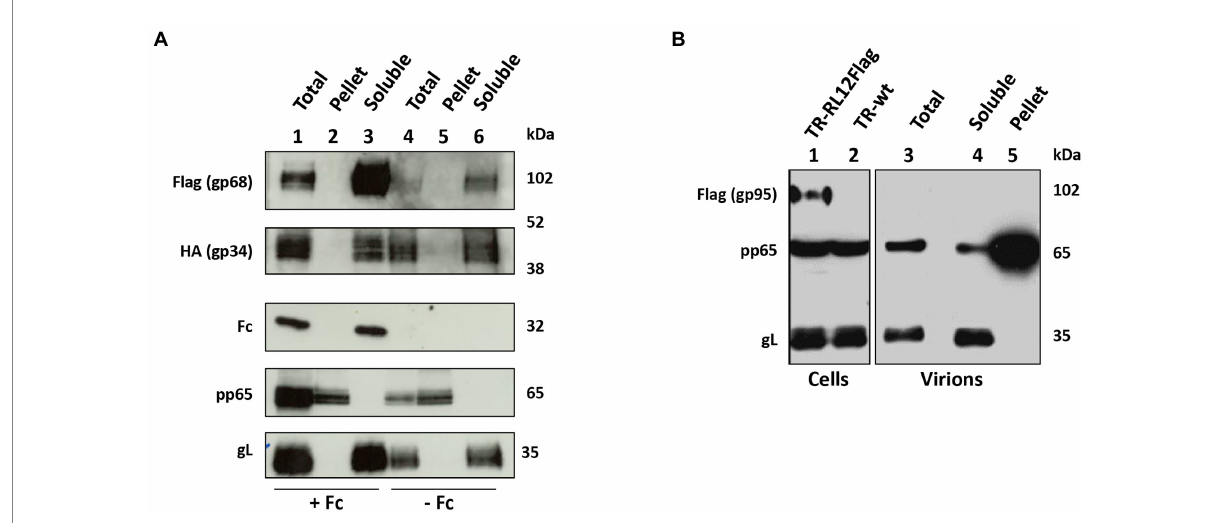
FIGURE 4 gp68 and gp34, but no gp95, are envelope proteins. (A) HFF-1 cells were infected at MOI 1 with either HCMV TR- UL119 Flag or RL11 HA in duplicate. Human Fc γ fragments were added to one sample for each virus while the other was grown in normal medium. At day 6 p.i., supernatants were harvested, virions purified through a glycerol/tartrate density gradient and tegument/capsid fraction (Pellet) was separated from envelope proteins (Soluble) through triton X-114 procedure. Lysates of infected cells and fractions of purified virions were analyzed through western blot using antibodies against gL, pp65, human IgG, anti-Flag, or anti-HA. (B) HFF-1 cells were infected at MOI 1 with HCMV TR- RL12 Flag. Infected cells were incubated with human Fcs as described above. At day 6 p.i., supernatants were harvested, and virions were purified through a glycerol/tartrate density gradient. Tegument/capsid fraction (Pellet) was separated from envelope proteins (soluble) through detergent extraction. Lysates of infected cells and fractions of purified virions were analyzed through western blot using indicated